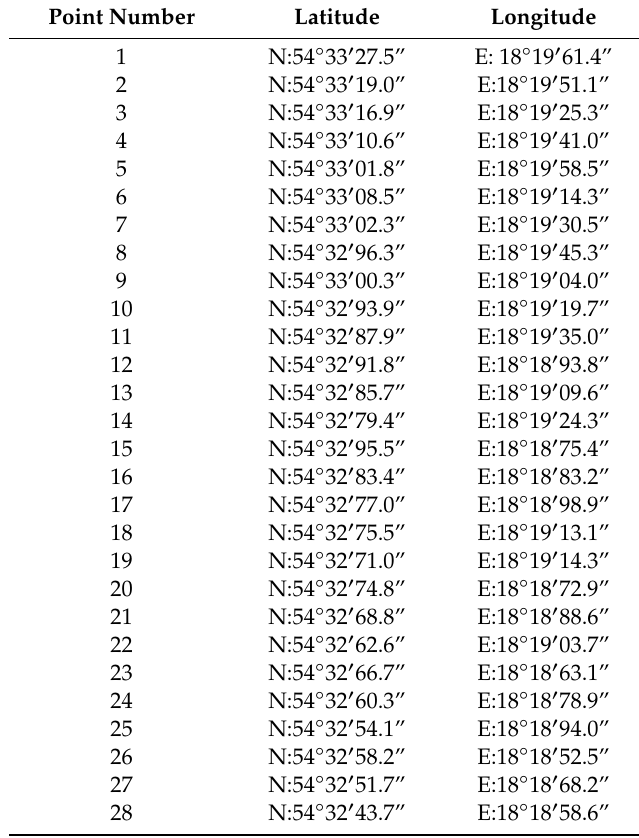
Table 2. Geographical coordinates of sediment sampling points from Karczemne Lake. Point